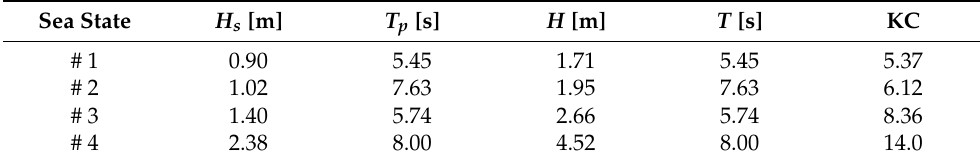
Table 2. Characteristics of the four sea states investigated as equivalent regular waves using